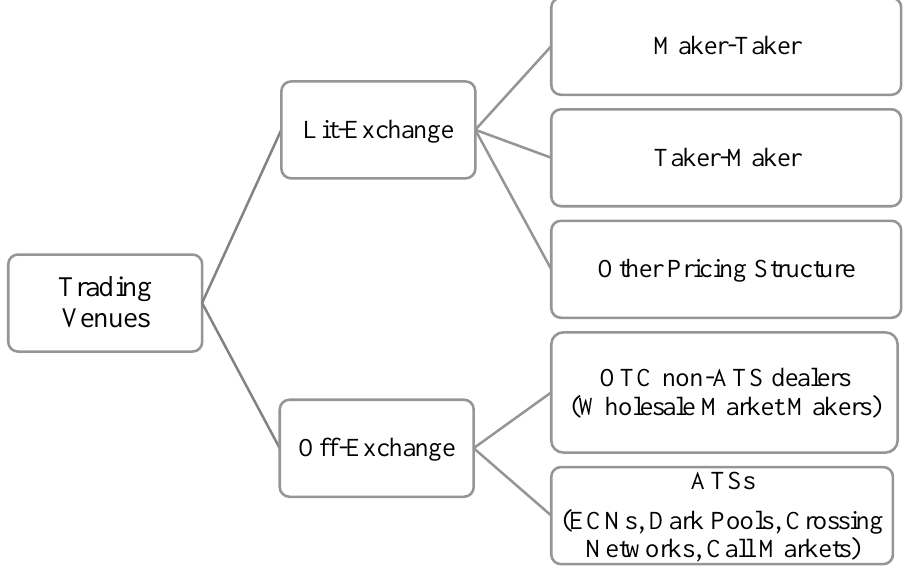
Figure 3. The U.S. Equity Market Structure.